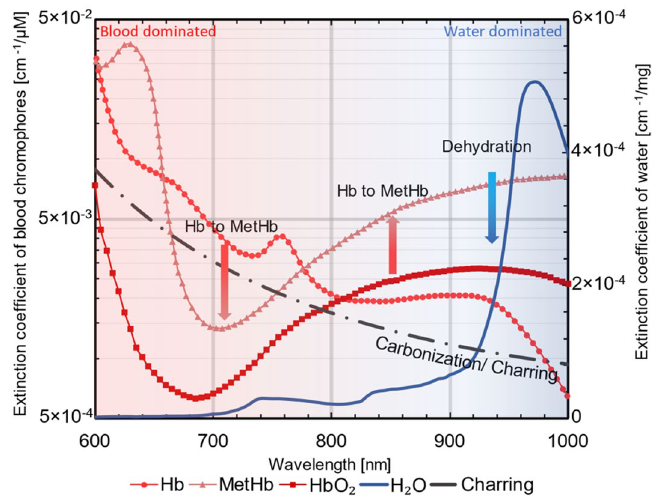
Figure 6. Extinction spectra of key absorbers in biological tissue undergoing thermal treatment. Blood chromophores (Hb, HbO 2 and MetHb) are plotted against the logarithmic y axis on the left. While the spectrum of water is plotted against the y-axis to the right. The dotted line decaying exponentially with wavelength represents the influence of charring on the absorption. The absorptivity on either side of the 800–900 nm wavelength region decreases with treatment. While the absorptivity in the region of 800–900 nm increases with thermal treatment as a consequence of the conversion of Hb and HbO 2 into MetHb. (Figure generated using data from